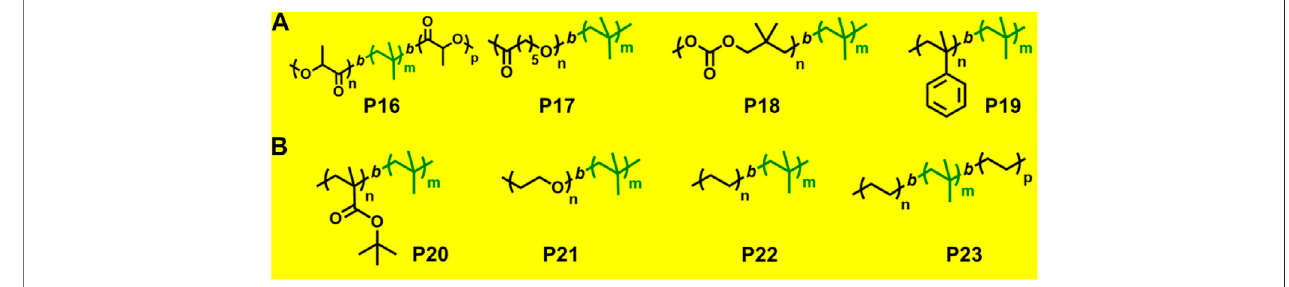
FIGURE6|(A) Examplesofblockcopolymerssynthesized via combinationoflivingcationicpolymerizationandring-openingpolymerization. (B) Examplesofblock copolymers synthesized via combination of living cationic polymerization with anionic polymerization and click chemistry.